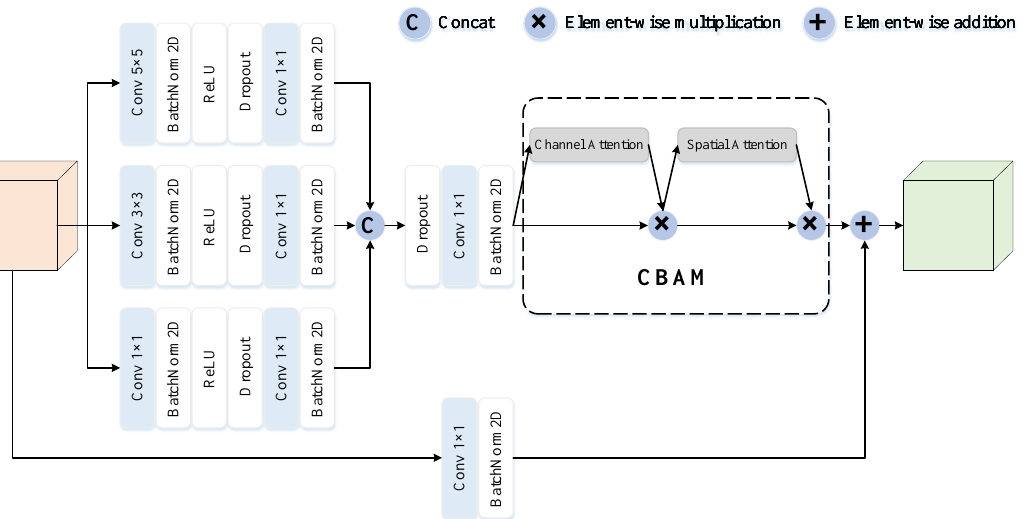
Figure 5. The framework of the MBE block. The MBE consists of a set of multiscale convolution and attention